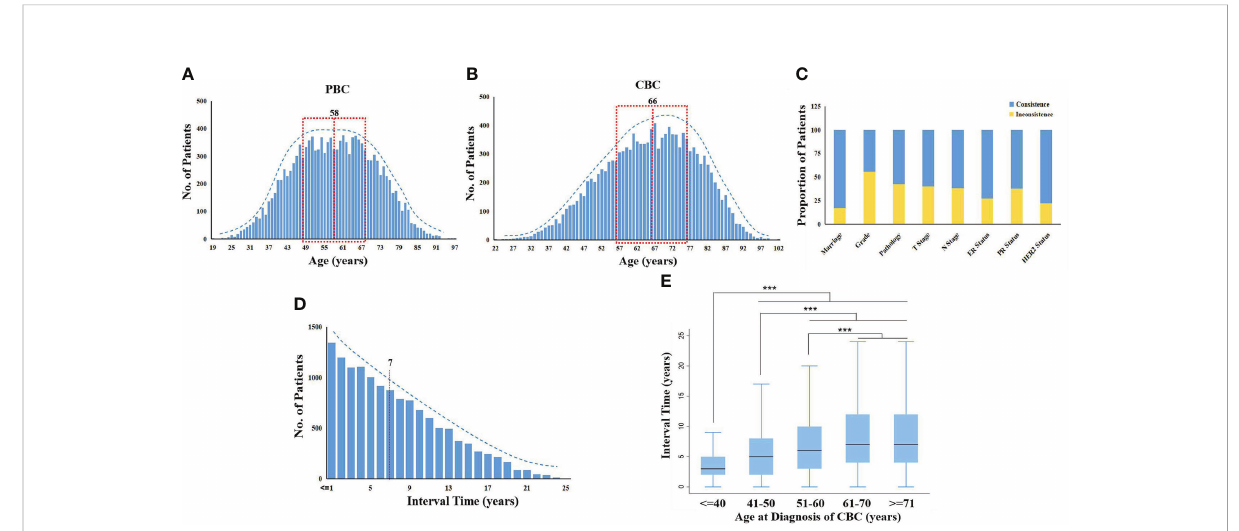
FIGURE 1 Distribution of clinical characters in MBBC from SEER. (A, B) Age distribution in MBBC: the number of patients plotted on the y -axis against age on the x -axis for PBC (A) and CBC (B) . The mean age of diagnosis with PBC and CBC was 58 versus 66 years, respectively. (C) The consistent radio by different clinical features on the y -axis against gender on the x -axis. (D) The number of patients with CBC plotted on the y-axis against the interval time, and the mean was 7 years. (E) Patients were divided into fi ve groups according to age at diagnosis of CBC ( ≤ 40, 41 – 50, 51 – 60, 61 – 70, ≥ 71), the range of interval time was counted on the x -axis. ***p <